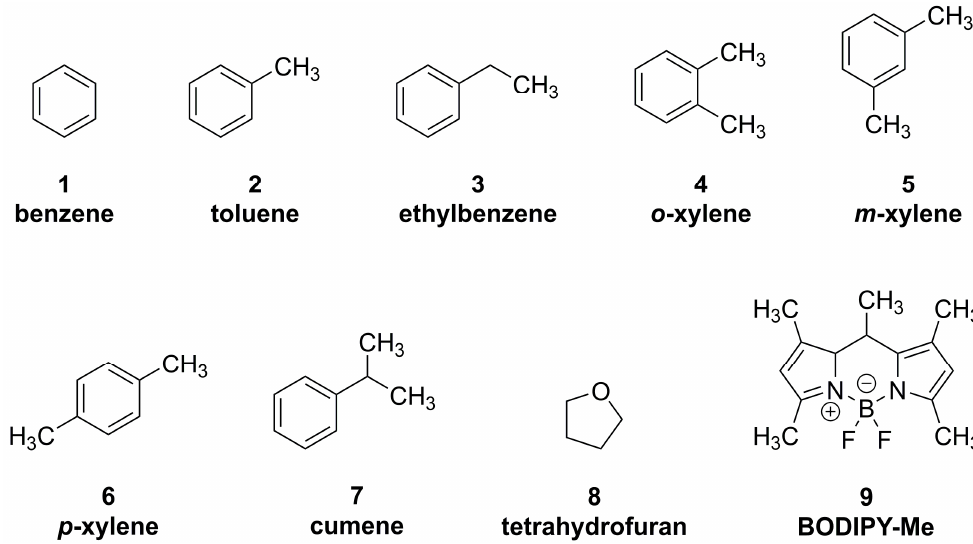
Figure 2. Structures of analytes 1 – 7 , control analyte 8 , and fluorophore 9 .